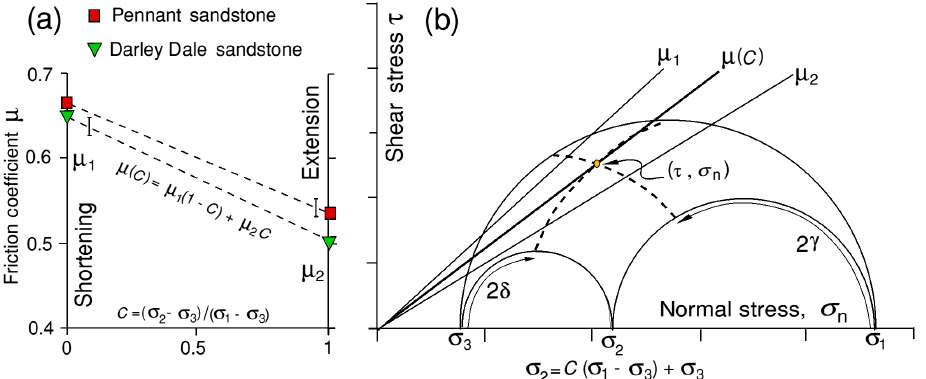
Figure 15. (a) Comparison of friction coefficients for Darley Dale and Pennant sandstones sheared in extension and shortening modes. The simplest assumption is that there is a linear variation of friction coefficient between the extremes shown. (b) Three-dimensional Mohr circle construction (no stress scales) to show how a general friction coefficient lies between the extremes of µ 1 (shortening) and µ 2 (extensional) loading. For a specified position of the intermediate principal stress σ 2 = C(σ 2 − σ 3 )/(σ 1 − σ 3 ) , there will be a particular friction coefficient µ(C) , along which combinations of resolved shear and normal stress corresponding to direction angles δ and γ will give rise to